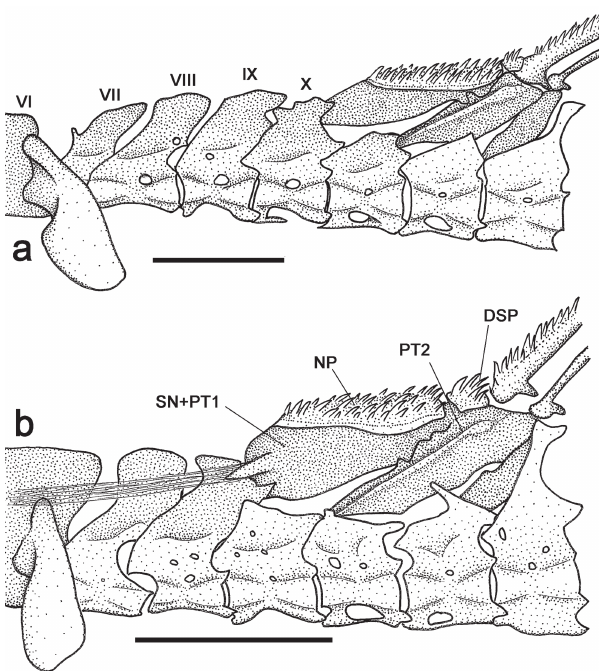
Fig. 3. Dorsal-fin skeleton of Microlepidogaster . a ) Microlepidogaster longicolla , MCP 23323; b ) M . perforatus , MCP 17717. DSP = dorsal-fin spinelet; NP = nuchal plate; PT2 = second dorsal-fin pterygiophore; SN+PT1 = fused supraneural and first dorsal-fin pterygiophore; VI-X = vertebrae VI th to X th . Scale bar = 2 mm.